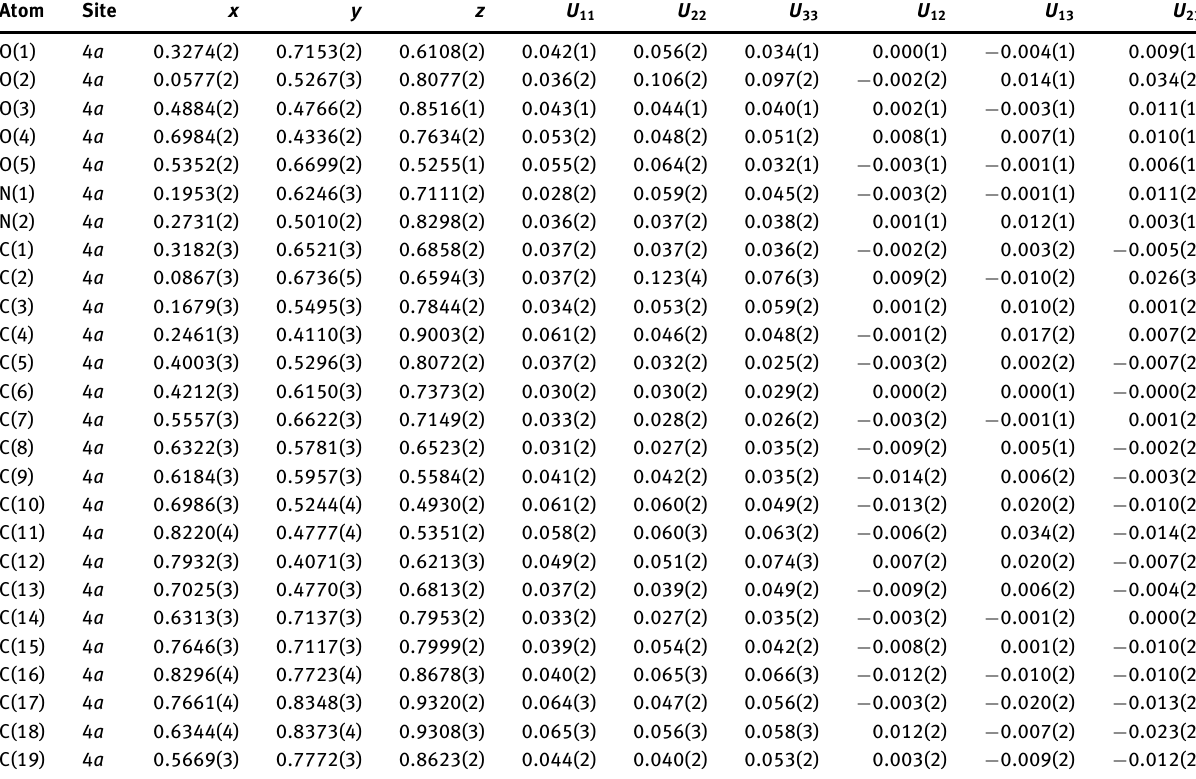
Table 3: Fractional coordinates and atomic displacement parameters (Å 2